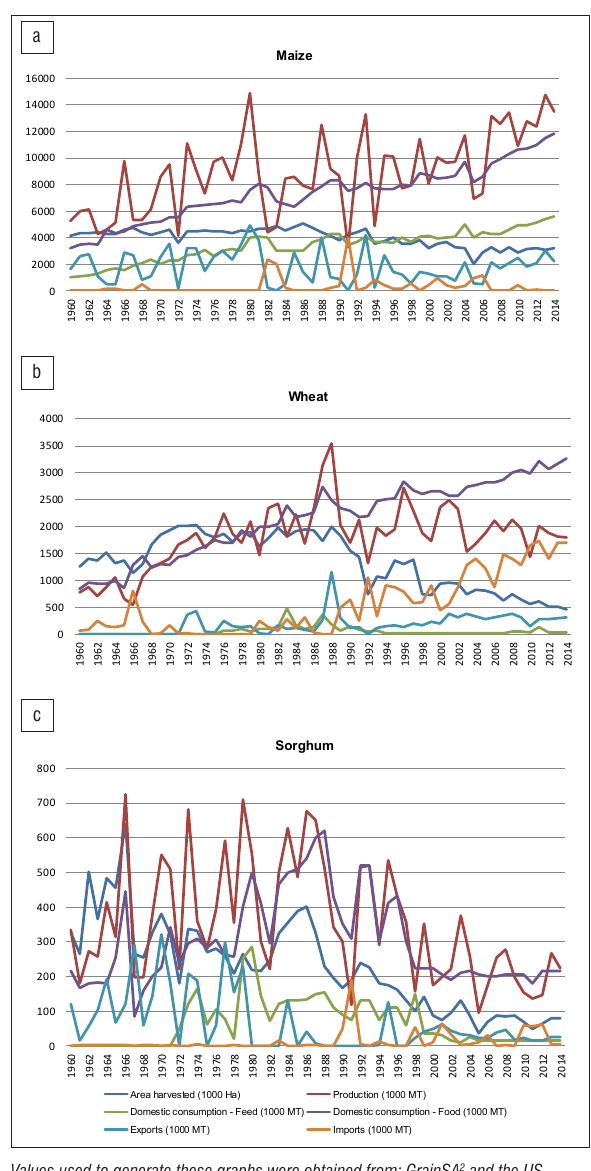
Figure 1: Cultivation, usage and trade in South Africa between 1960 and 2014 of (a) maize, (b) wheat and (c) sorghum.